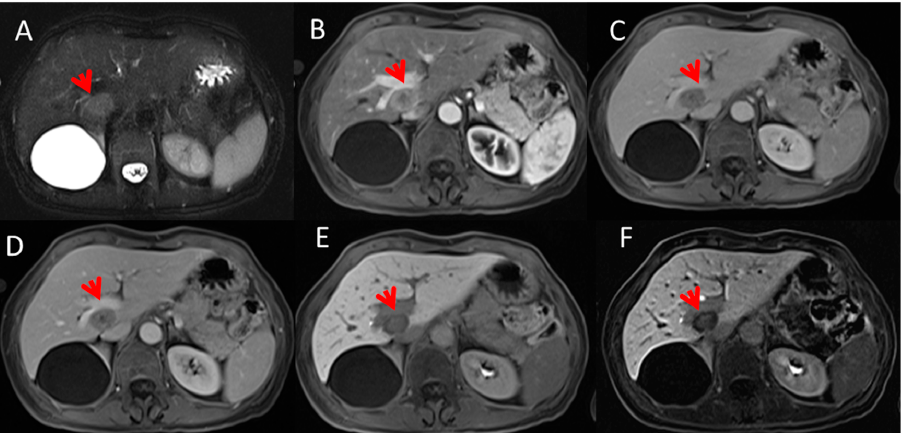
Figure 1. 63 year-old man with rectal cancer. Liver metastasis on I hepatic segment. In ( A ) (TRUFISP T2-W fat sat) the lesion (arrow) is hyperintense. Contrast study with Gd-EOB-DTPA: the lesion (arrow) shows a peripheral rim enhancement with a hypointense core, in arterial phase ( B ). In the portal ( C ) and transitional phase ( D ), the lesion is hypointense. In the HPB phase ( E , F ), the lesion is hypointense, with a target appearance.